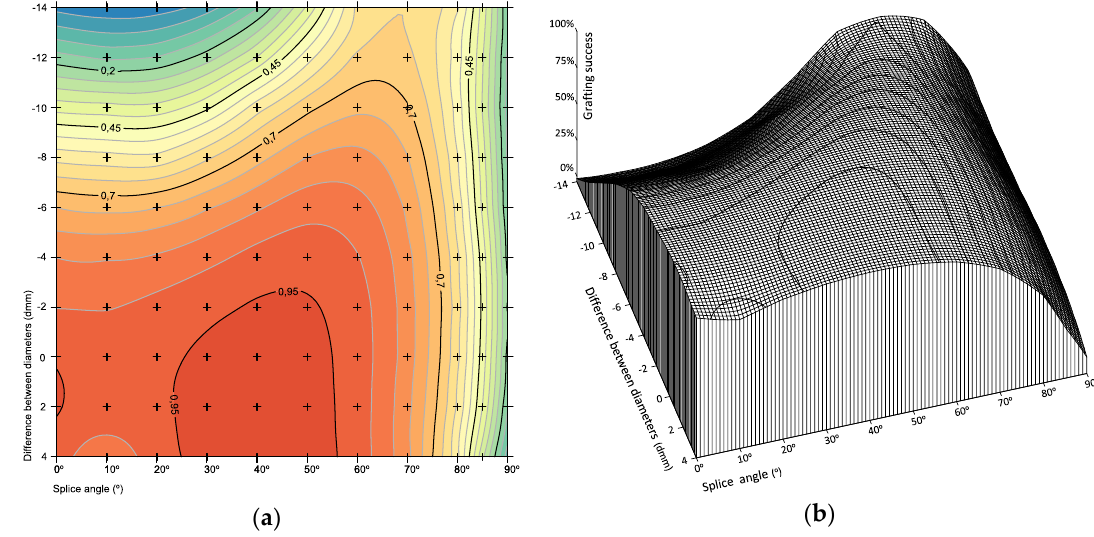
Figure 6. Graphical representation of the combined influence of cutting angle and diameter differences